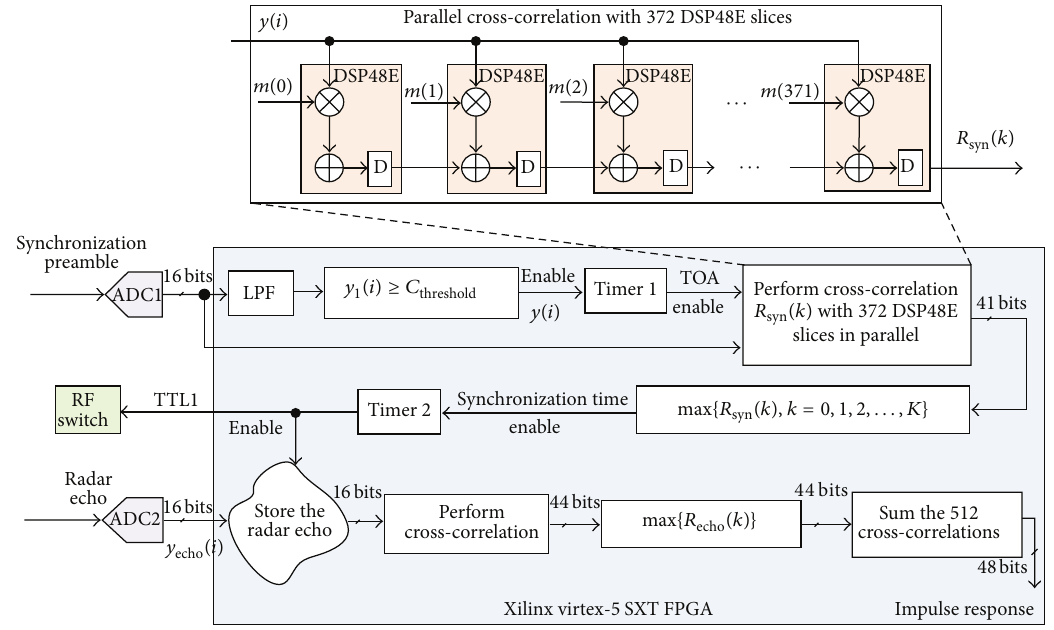
Figure 4: Estimation of the synchronization time based on